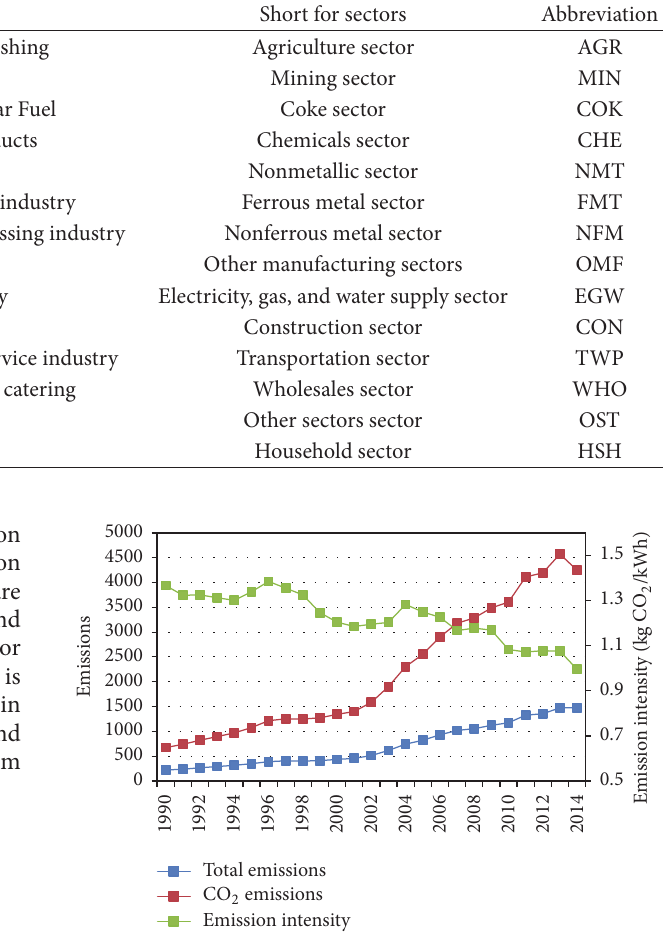
Figure 1: CO 2 emission trends in China’s power sector during 1990–